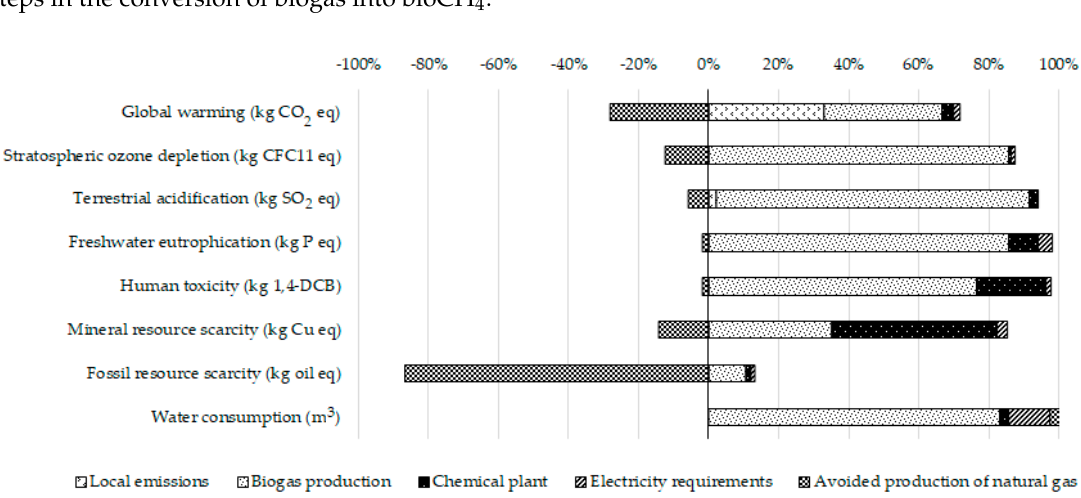
Figure 2. Breakdown of characterized impacts for different steps of the membrane upgrading technology (negative values = environmental credits).